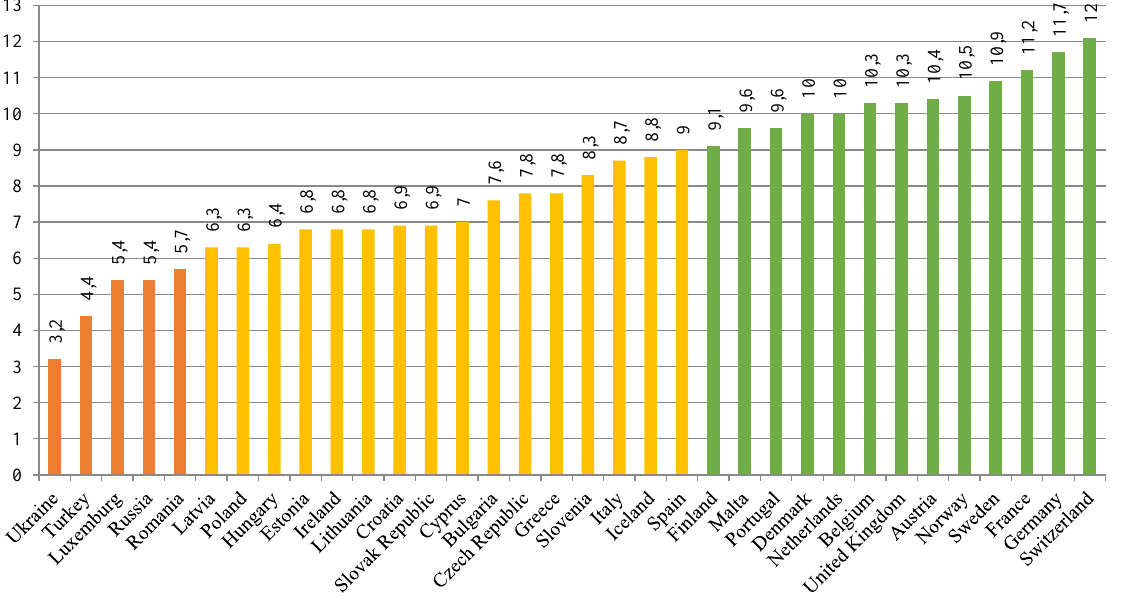
Fig. 3. Level of health expenditure in 2019 (% of